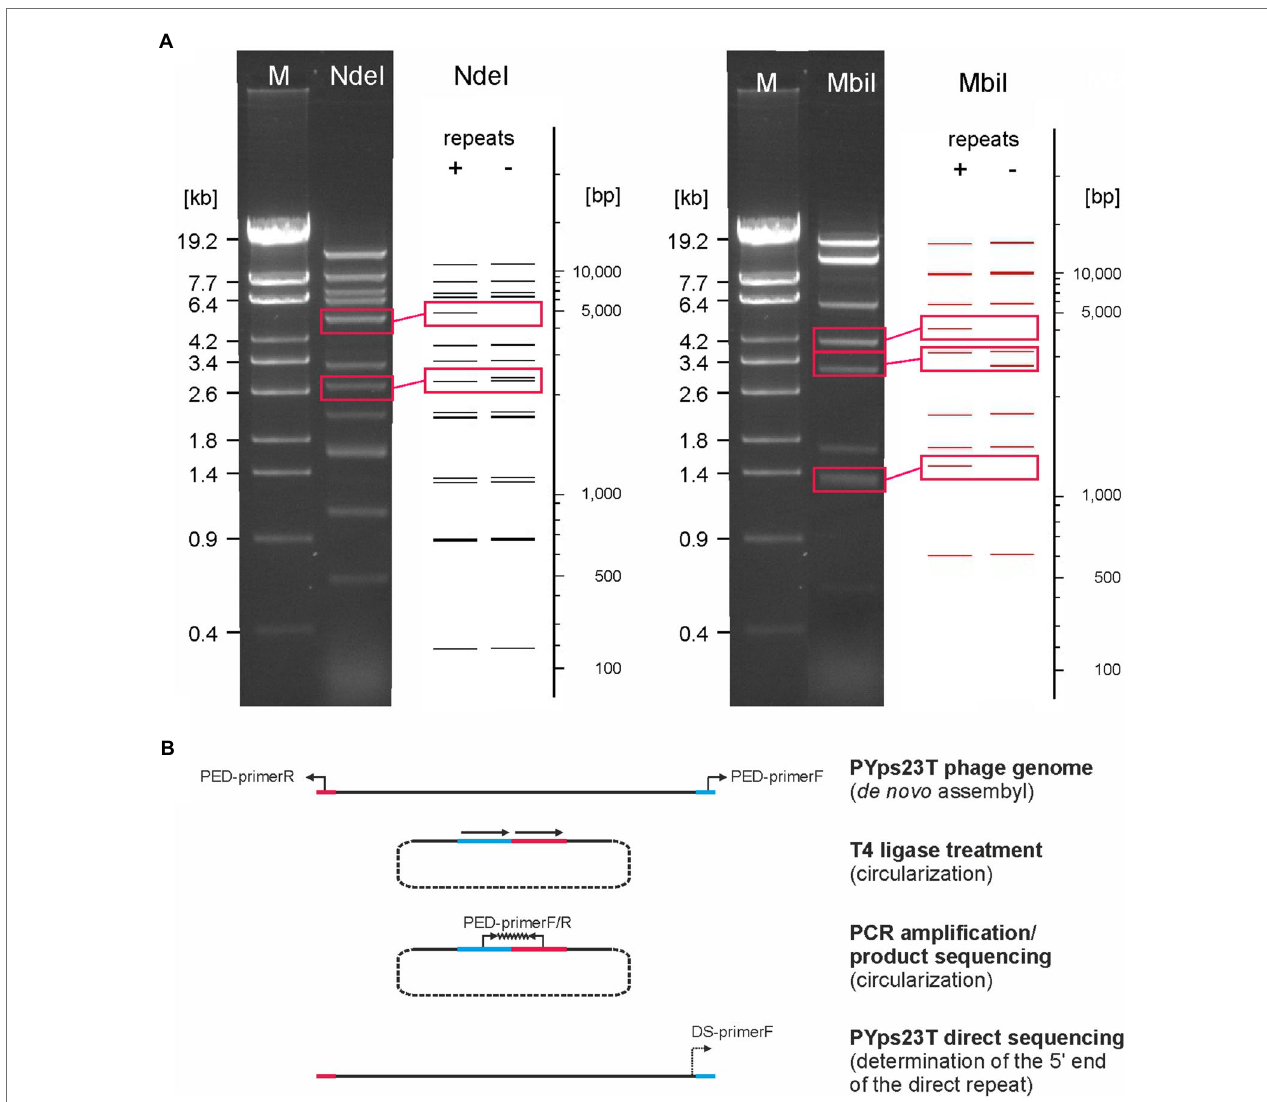
FIGURE 5 | The PYps23T genome contains long terminal direct repeats. (A) MbiI and NdeI restriction patterns of the phage DNA obtained by agarose gel electrophoresis and by in silico analysis. Fragments that were present only in the gel or in the in silico analysis are boxed. In silico restriction pattern predictions of PYps23T were obtained using NEBcutter v2.0 (Vincze et al., 2003). Shown are patterns of the PYps23T genome without and with terminal repeats of 2.3 kb. M, Lambda Eco32I marker (fragment sizes are given). (B) . Determination of the start and end of the direct repeat. PED, PCR End Determination primer; DS, Direct Sequencing primer. See the text for